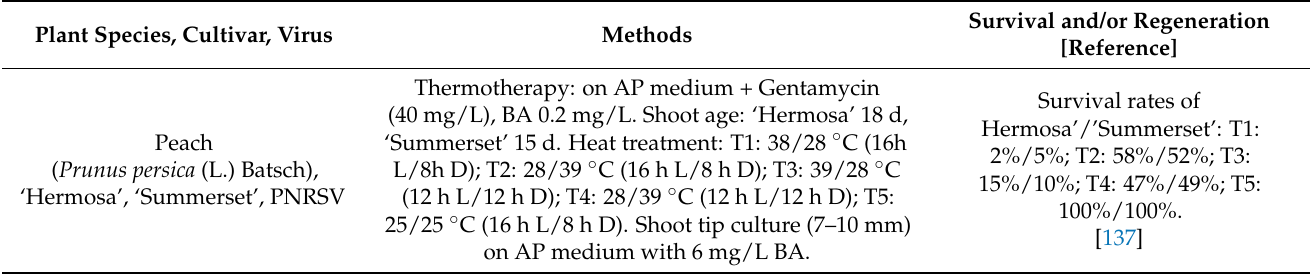
Survival and/or Regeneration